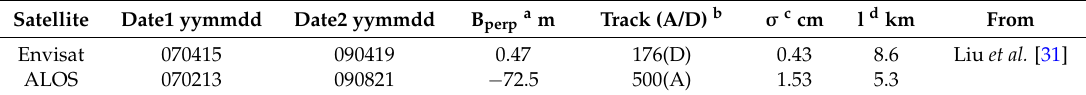
Table 1. SAR satellite data used in this work.